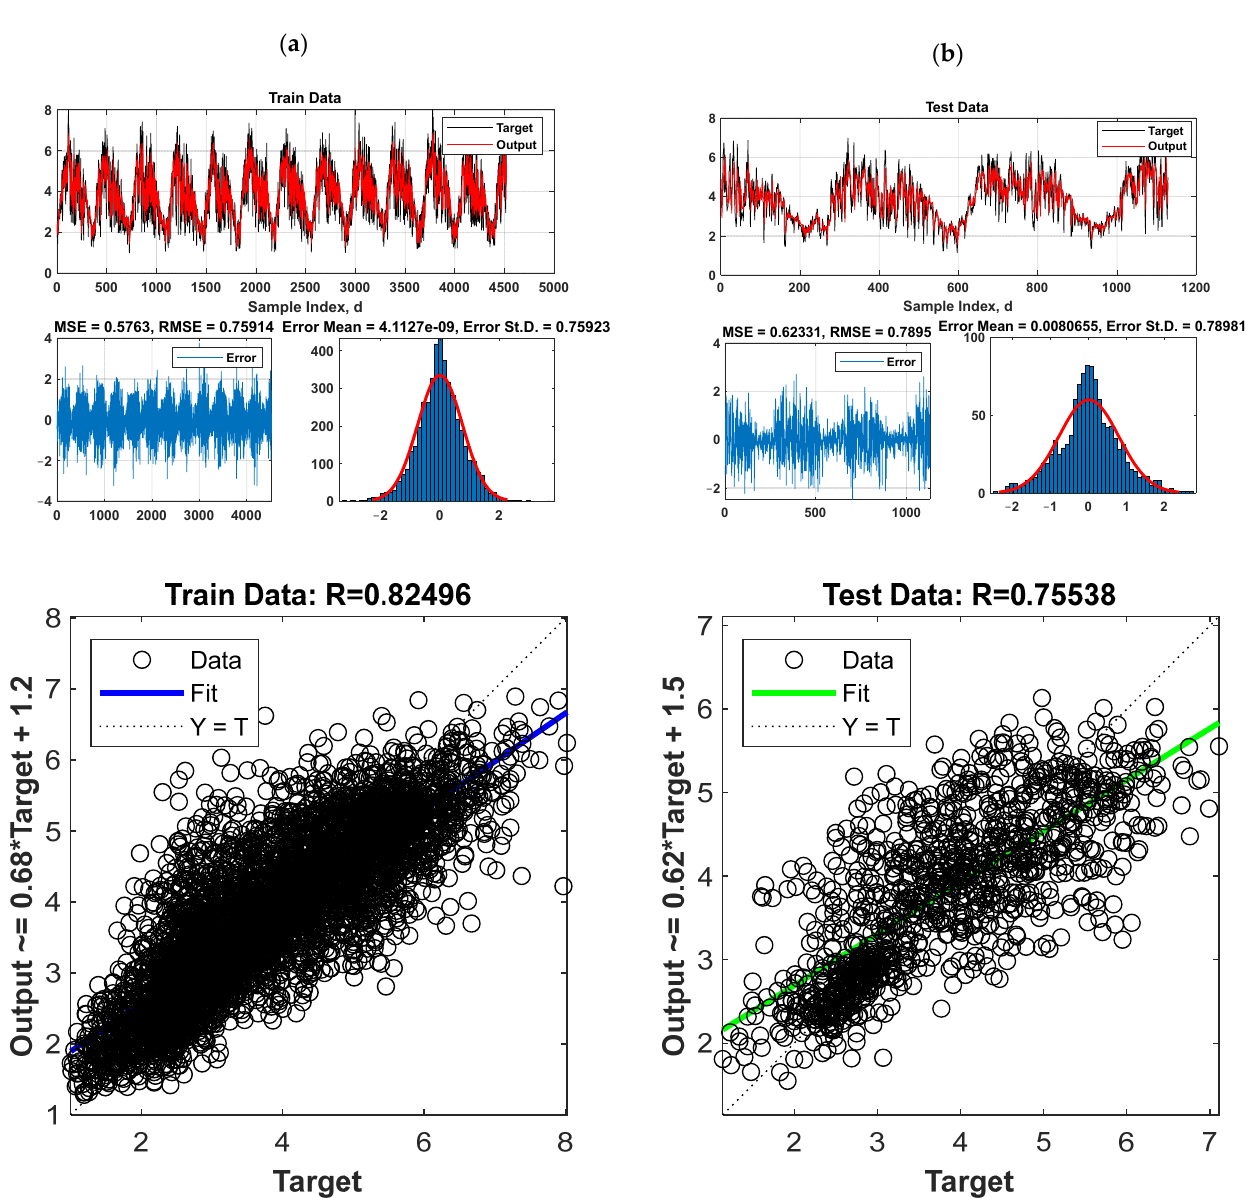
Figure 7. Scatter plots and regression plots for the values of FAO-56 PM-calculated ET 0 and ANFIS- forecasted ET 0 for the training ( a ) and testing ( b ) phases. Table 9. Performance indices of the one-day-ahead ET 0 prediction models for the testing dataset.